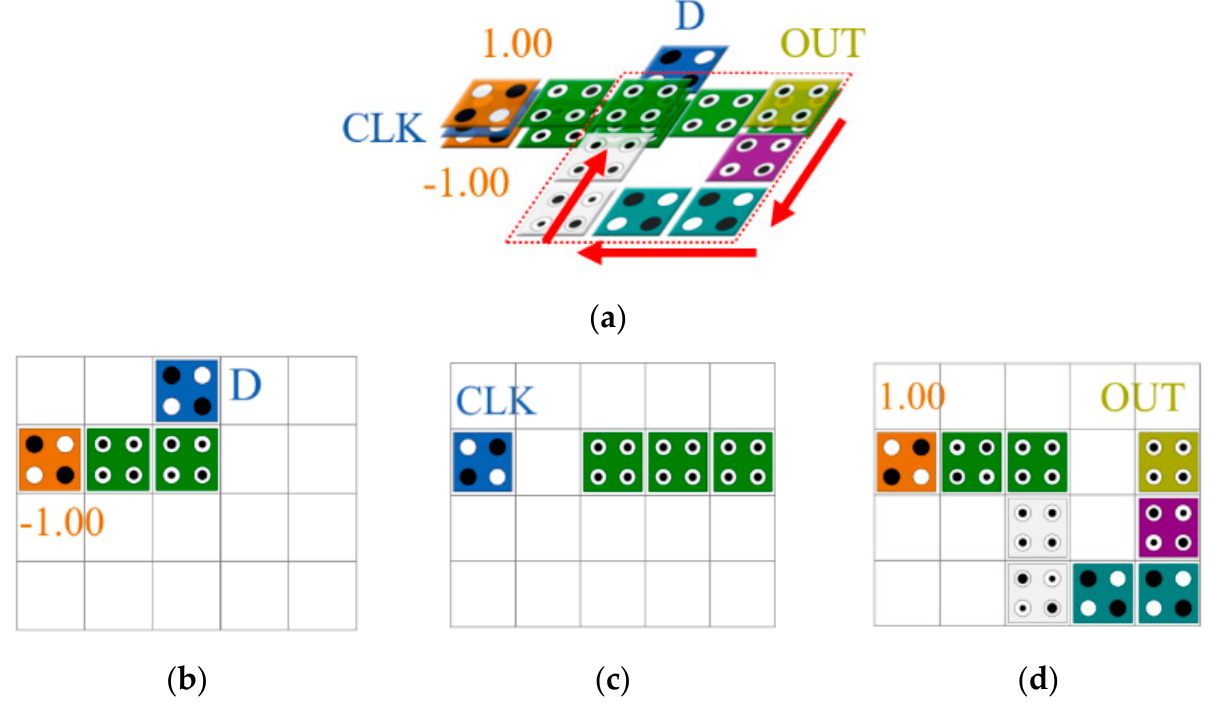
Figure 11. Proposed D-latch: ( a ) full circuit; ( b ) layer 1; ( c ) layer 2; and ( d ) layer 3.